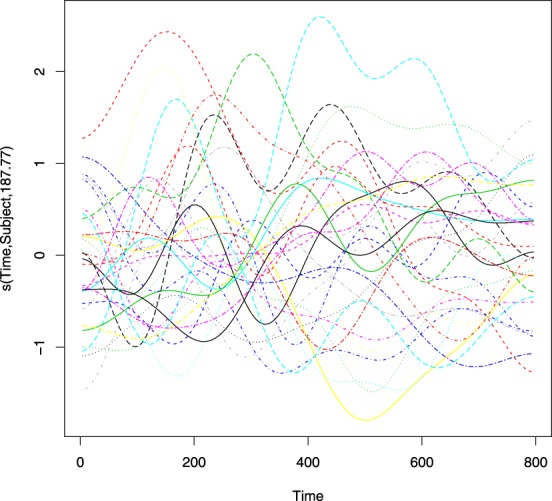
Average amplitude (μV) over time (ms) by participant at electrode C3. Each line corresponds to a participant.